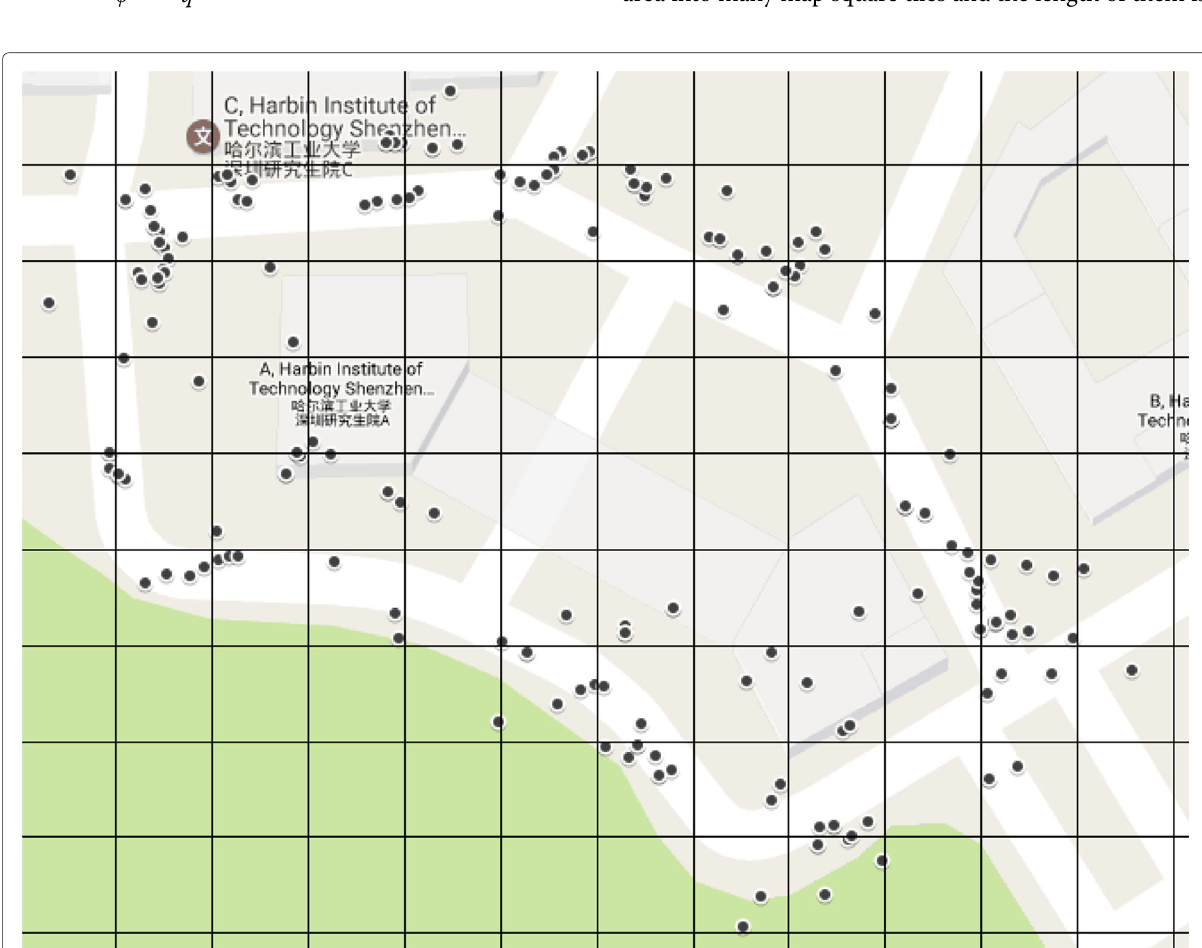
Fig. 5 Crowdsourcing data distribution in map